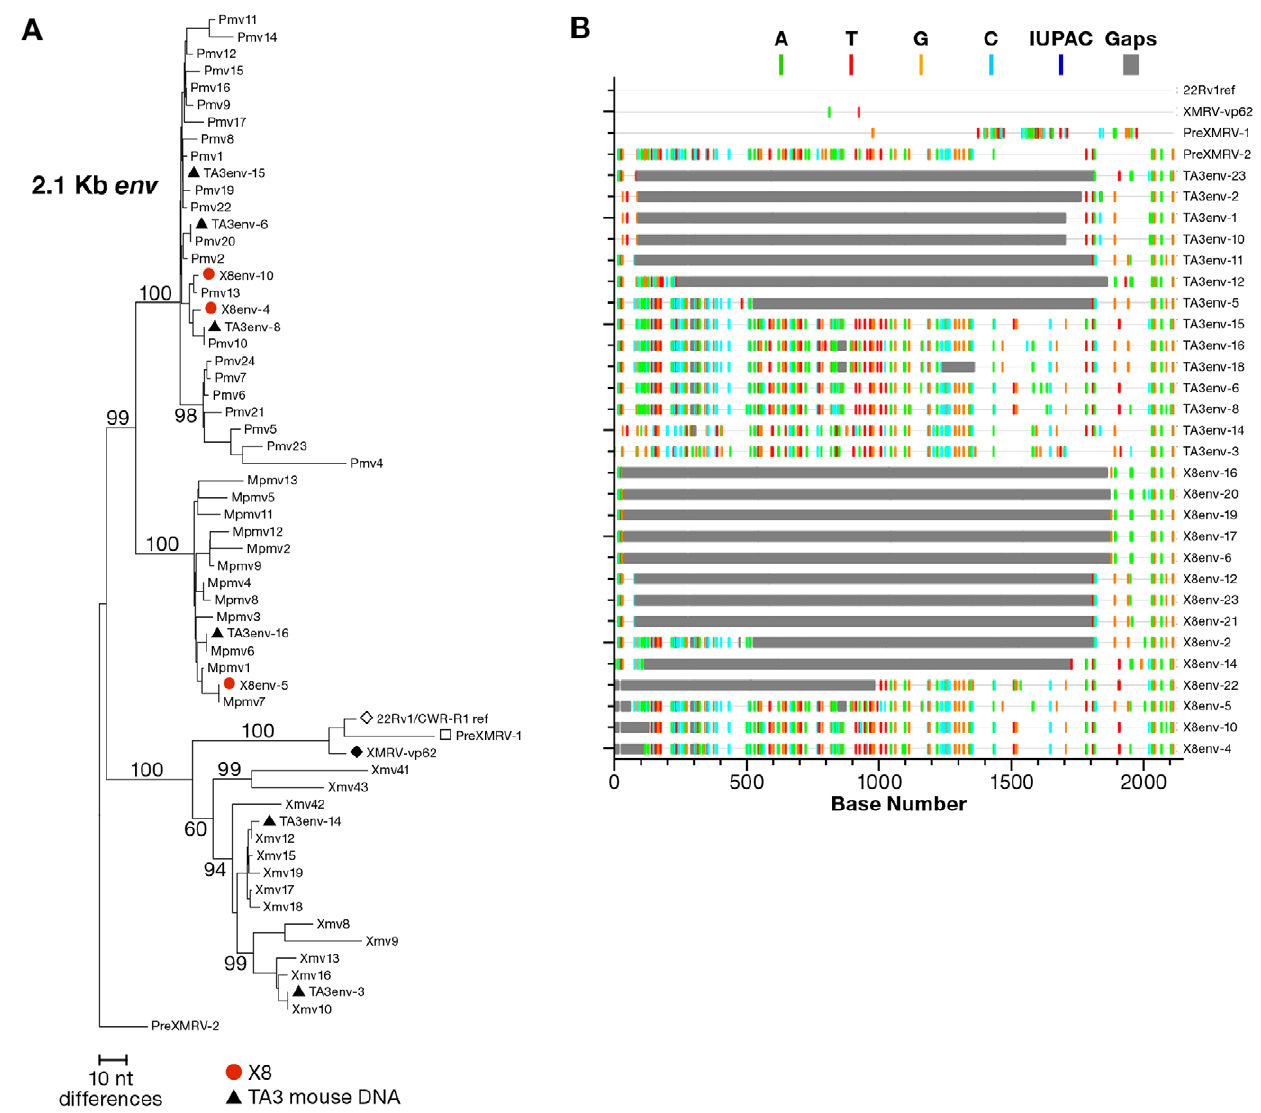
Figure 3. Env sequences obtained from plasma of patient X8. (a) Neighbor-joining analysis of full-length env sequences from patient X8, the full length TA3 sequences, and endogenous MLV as shown in Figure 2. (b) Highlighter plot of single-genome sequence alignment of env sequences from patient X8 and from TA3.CycT1 mouse cells.